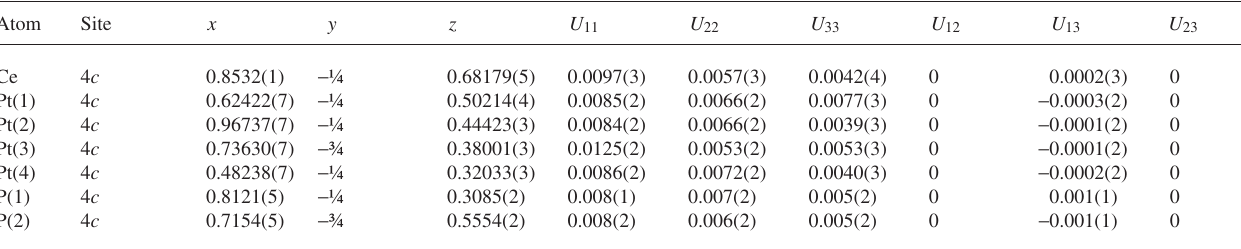
Table 2. Atomic coordinates and displacement parameters (in Å 2 )